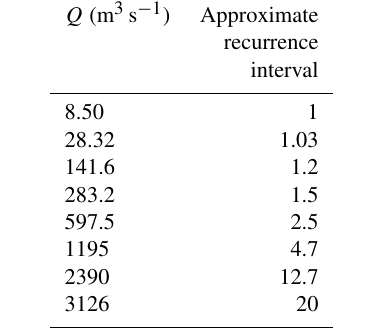
Table 1. Flows analyzed and their approximate recurrence